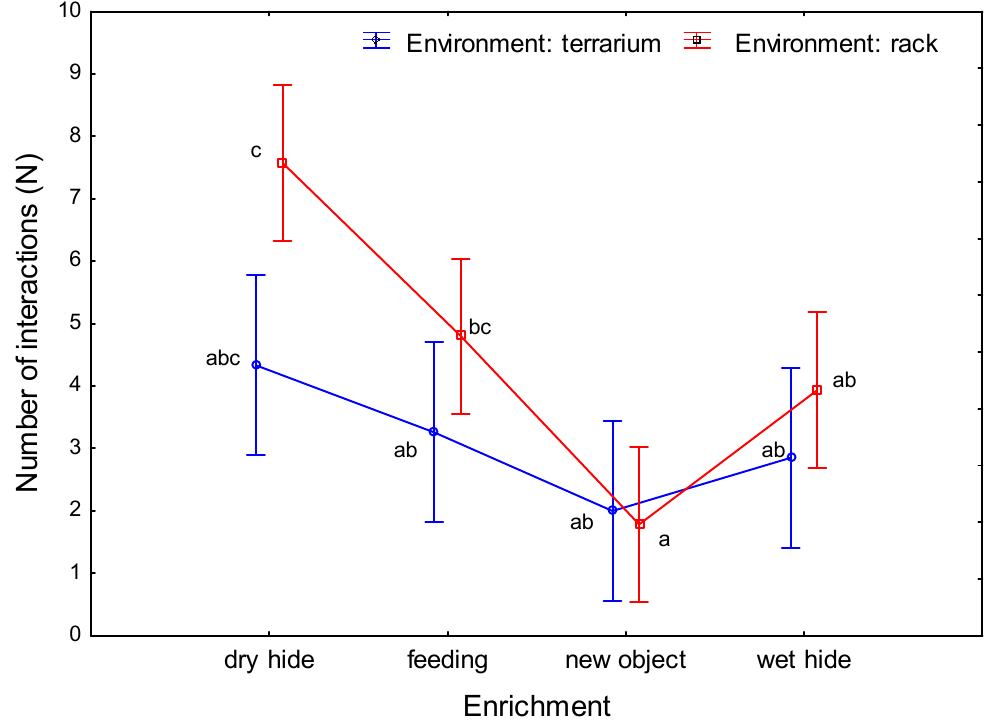
Figure 4. Average number of interactions (N) with enrichment for tested environments (terrarium, rack) and enrichment items (vertical bars denote 0.95 confidence intervals; groups that do not share a common letter differ signi fi cantly).